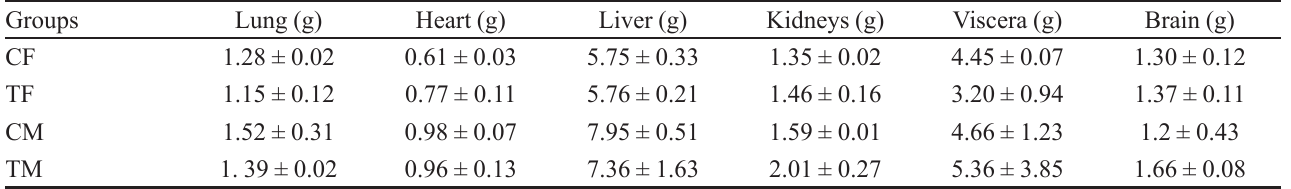
CF = control female; CM = control male; TF = treated female; TM = treated male. Data are expressed as mean ± standard deviation (SD), n =